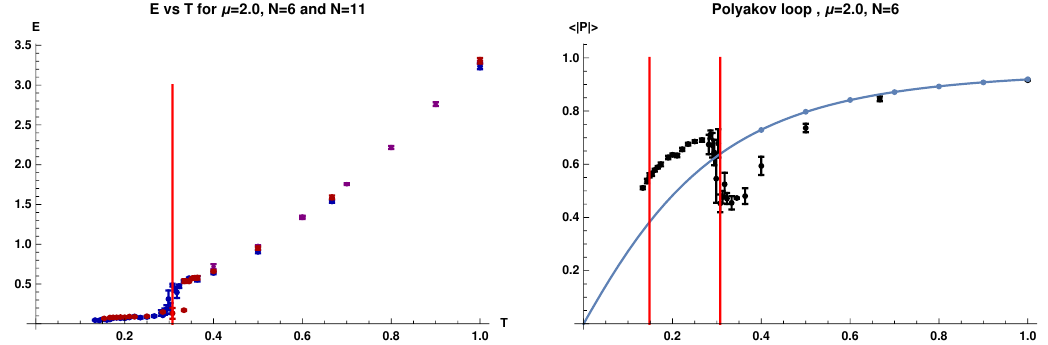
Figure 4 . The left (cid:12)gure shows superimposed energy curves for N = 6 and N = 11. The right (cid:12)gure shows hj P ji for N = 6, (cid:22) = 2 : 0 and (cid:3) = 24. The N = 6 transition is taken to be at T c = 0 : 31 (cid:6) 0 : 02. Both plots include the BFSS energy (i.e. (cid:22) = 0) and hj P ji values for N = 24, (cid:3) = 24. This data was used in the 1 =N extrapolation in (cid:12)gure 5.